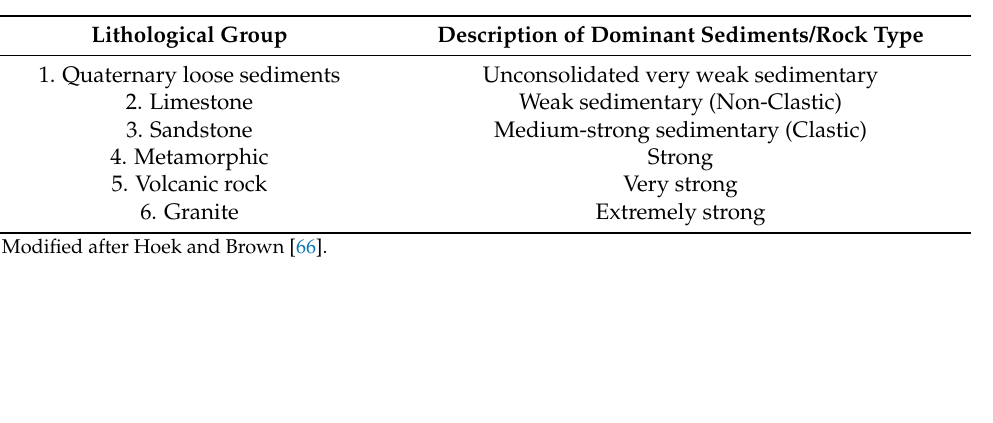
Table 1. Description of classified lithological groups and of the Rock Strength Levels that increase from “Quaternary” to “Granite” 1